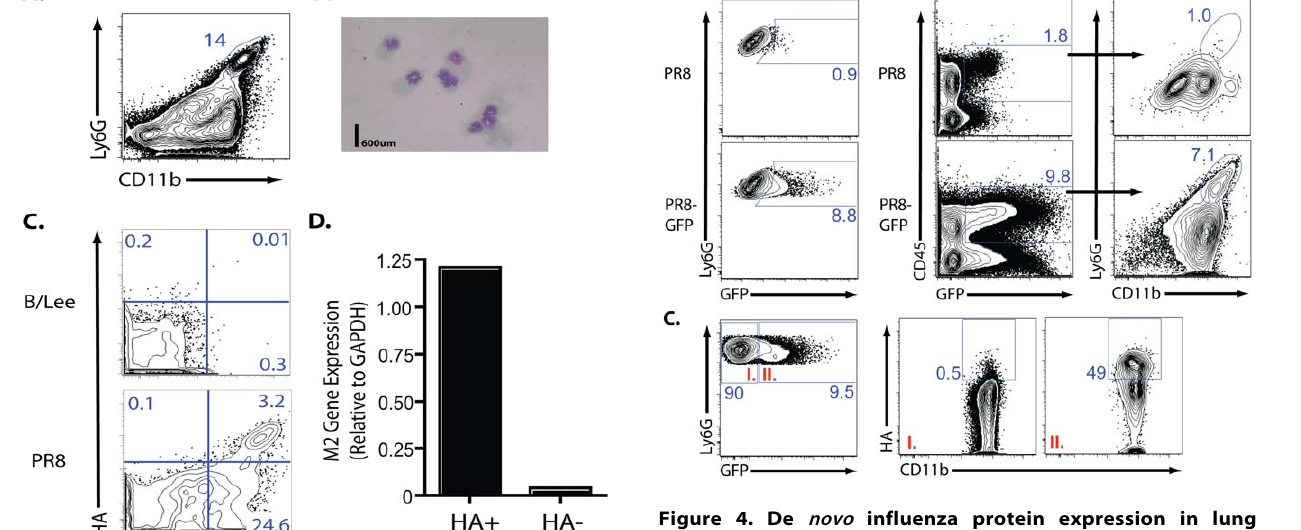
Figure 4. De novo influenza protein expression in lung neutrophils. ( A–B ) C57BL/6 mice were infected with NS-GFP or PR8 (10LD 50 ) influenza virus. At 5 dpi, total lungs were collected. Representative flow profile of ( A ) total lung neutrophil GFP expression and ( B ) the percent of neutrophils present of total GFP + hematopoietic cells. ( A–B ) Two independent experiments (n=3–4/expt). ( C ) BALB/c mice were infected with NS-GFP influenza virus. At 5 dpi, total lung was collected. Representative flow profile GFP + and GFP 2 neutrophil HA staining. Two independent experiments (n=2/expt). ( A–C ) Neutrophils gated as CD45 + Ly6G + CD11b hi . GFP gate was set utilizing splenic cells from infected animals. HA gate was set utilizing isotype control.